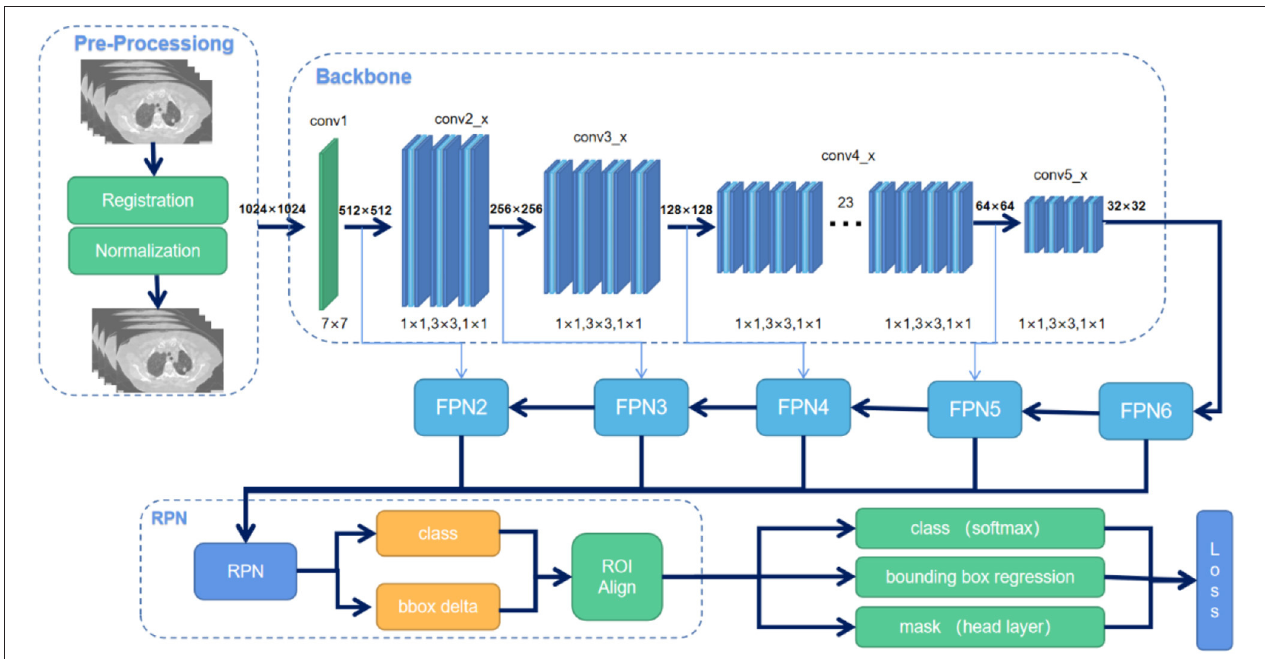
FIGURE 2 | Volumetric-modulated arc therapy (VMAT) plans with a full arc.